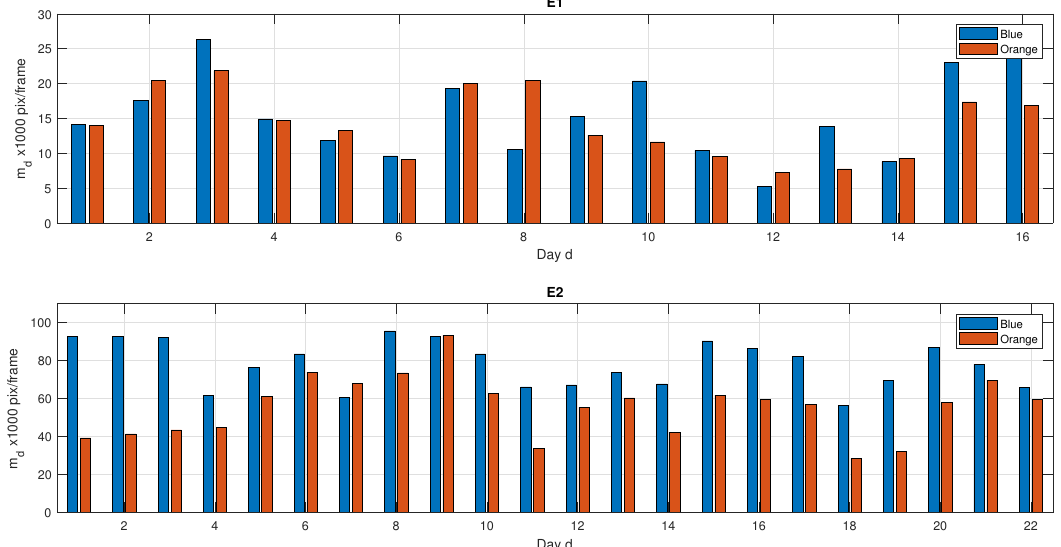
Figure 6. Daily motion along both experiments, E1 and E2. Daily motion m d computed in each experiment for animals with blue/orange collars. Top: both animals are infected with ASFV Arm07. Bottom: orange specimen (two animals) were infected with ASFV Arm07, blue specimen (four animals) were vaccinated with